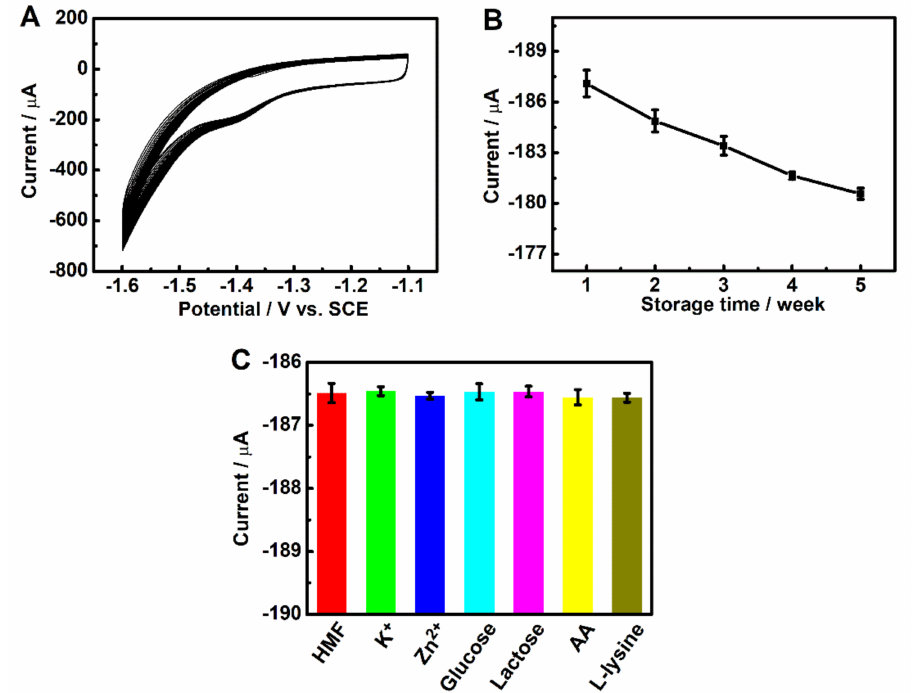
Figure 7. ( A ) CV curves of 100 consecutive scans of 50- µ M HMF in pH 9.18 PBS solution at 3DGrls/PGE, and ( B ) the current responses after storage in a refrigerator for 1, 2, 3, 4 and 5 weeks. Scan rate: 50 mV s − 1 . ( C ) The reduction peak current in the presence of interfering